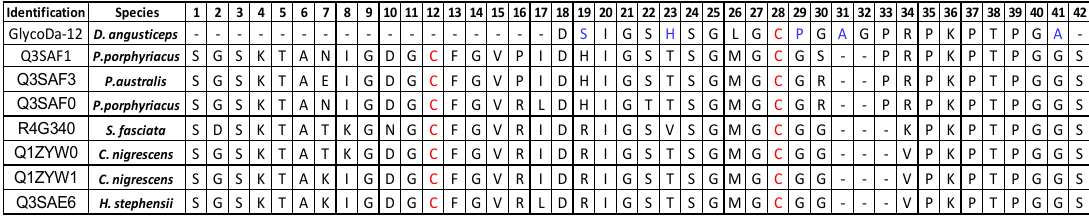
Figure 8. BLAST result for GlycoDa-12 toxin. In red, conserved cysteines, in blue amino acids which are different than database sequences